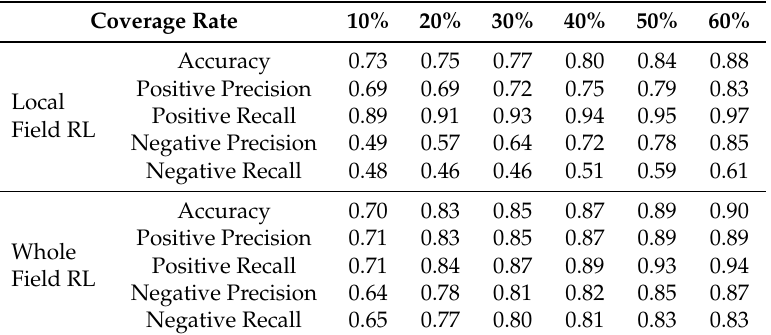
Table 2. Accuracy, precision and recall for maps generated using whole-field and local-field RL at different coverage